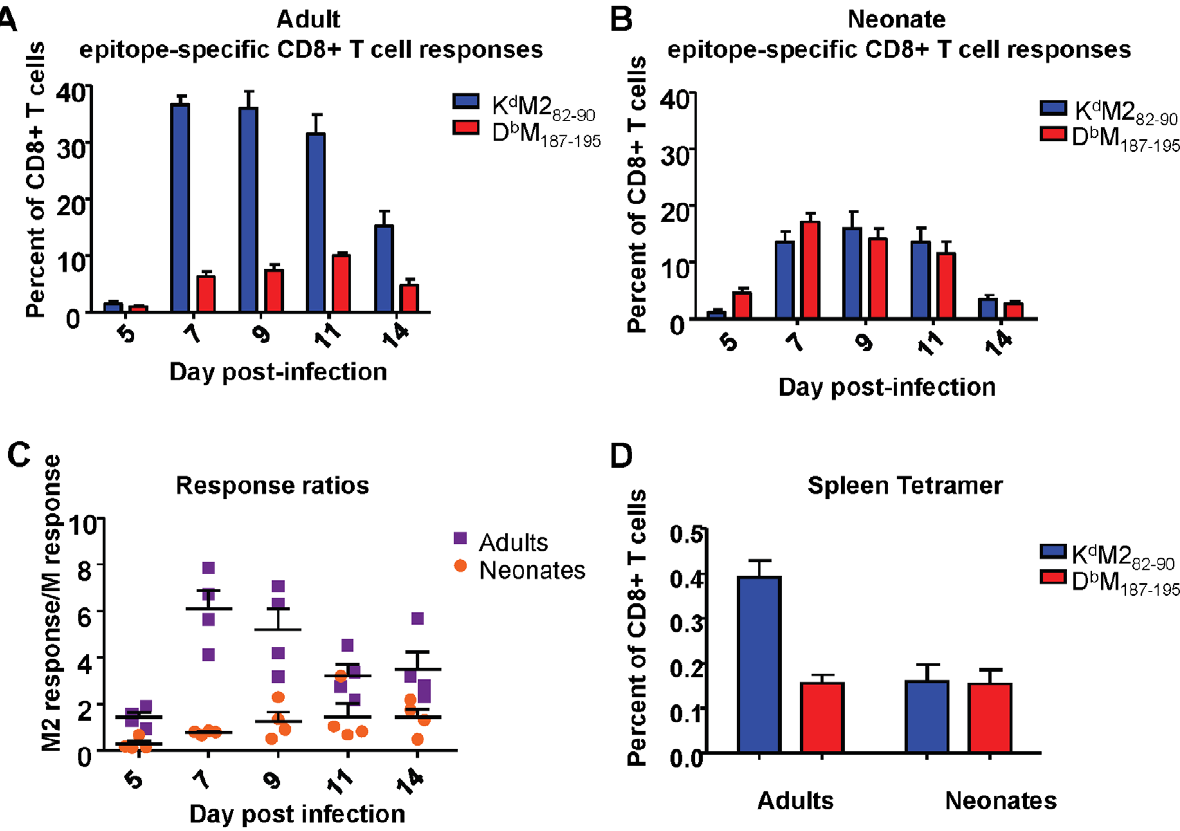
Figure 2. RSV epitope-specific CD8 + T cell responses during acute infection and memory. (A) Tetramer-positive cells specific for K d M2 82-90 and D b M 187-195 were measured in the lung at days 5-14 following infection of adult mice. Percentages of CD3 + CD8 + cells staining with the indicated tetramers are shown. (B) Epitope-specific CD8 + T cell responses to K d M2 82-90 and D b M 187-195 measured in the lung at 5-14 days post-infection in neonatal CB6F1 mice. (C) Epitope response ratios (K d M2 82-90 /D b M 187-195 ) measured from lung tissue at days 5-14 post-infection of adult and neonatal mice (D) Epitope-specific memory CD8 + T cell responses in the spleens of mice infected 72 days earlier as adults or neonates. Data are representative of 2-3 independent experiments with 4-8 mice/group. Error bars represent the SEM.